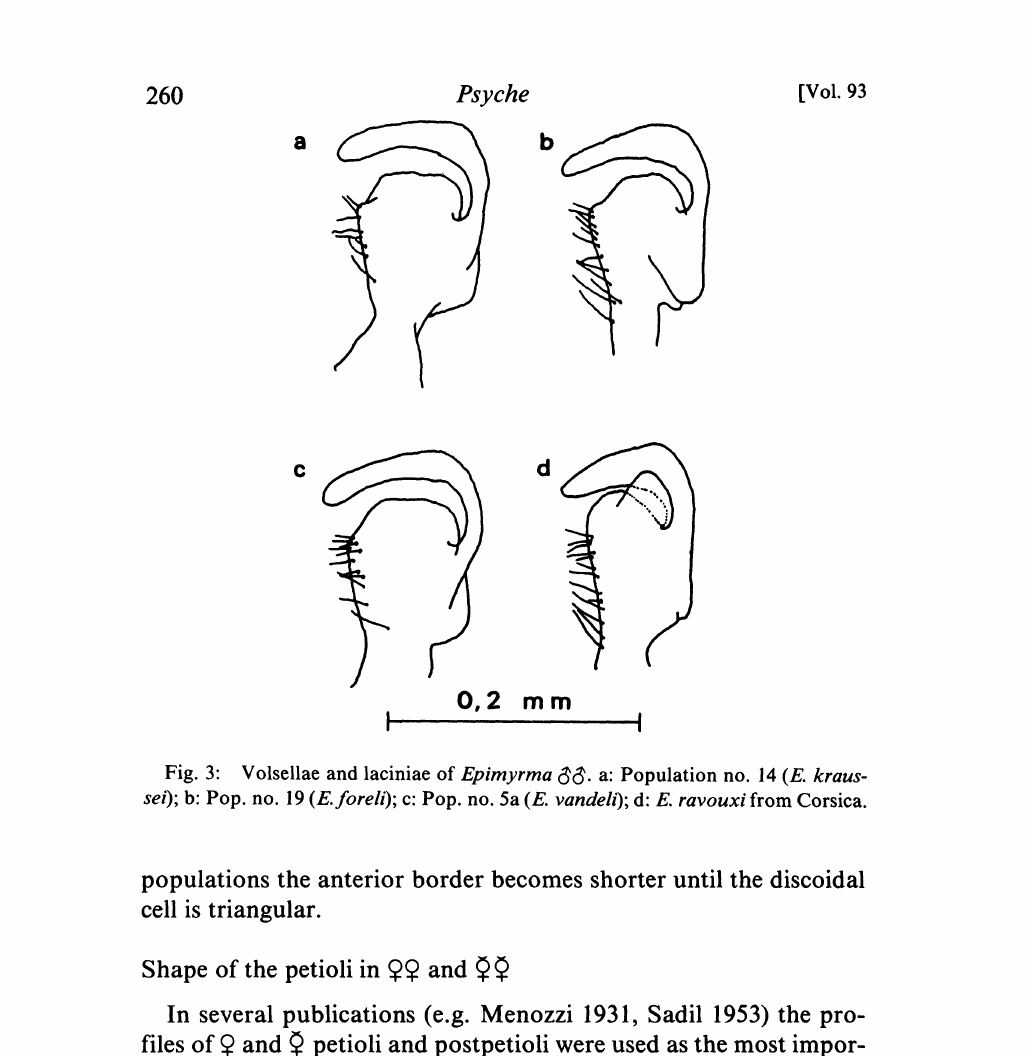
Fig. 3: Volsellae and laciniae of Epimyrma cc. a: Population no. 14 (E. kraus- sei); b: Pop. no. 19(E.foreli); c: Pop. no. 5a(E. vandeli); d: E. ravouxifrom Corsica. populations the anterior border becomes shorter until the discoidal cell is